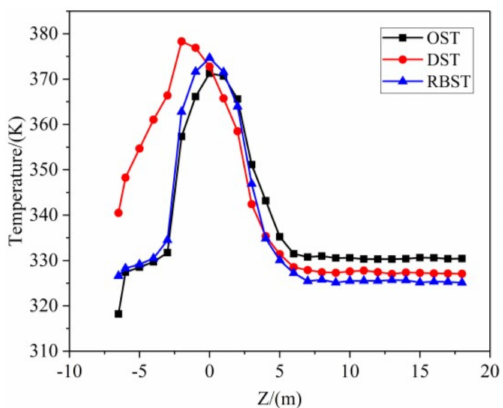
Figure 9. Average temperature in the plane at different